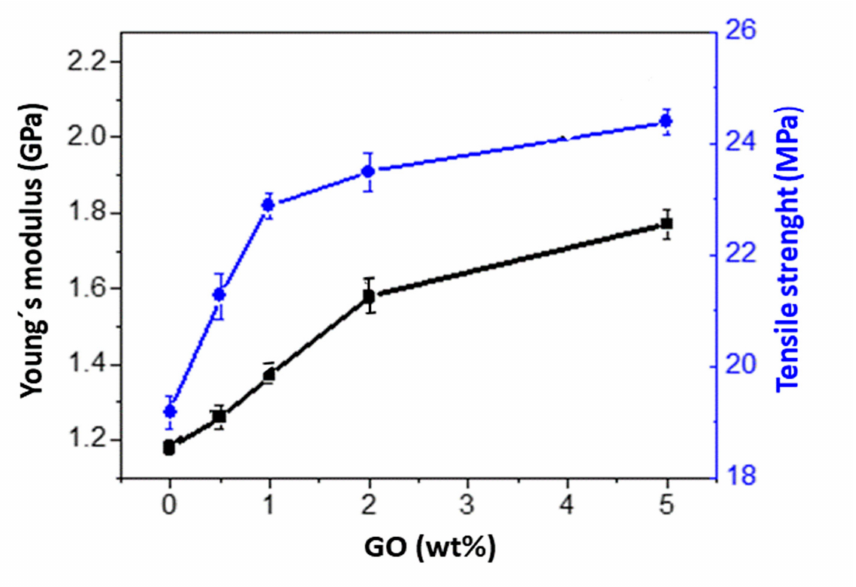
Figure 5. Young ´ s modulus and tensile strength of PHBHHx nanocomposites as a function of GO